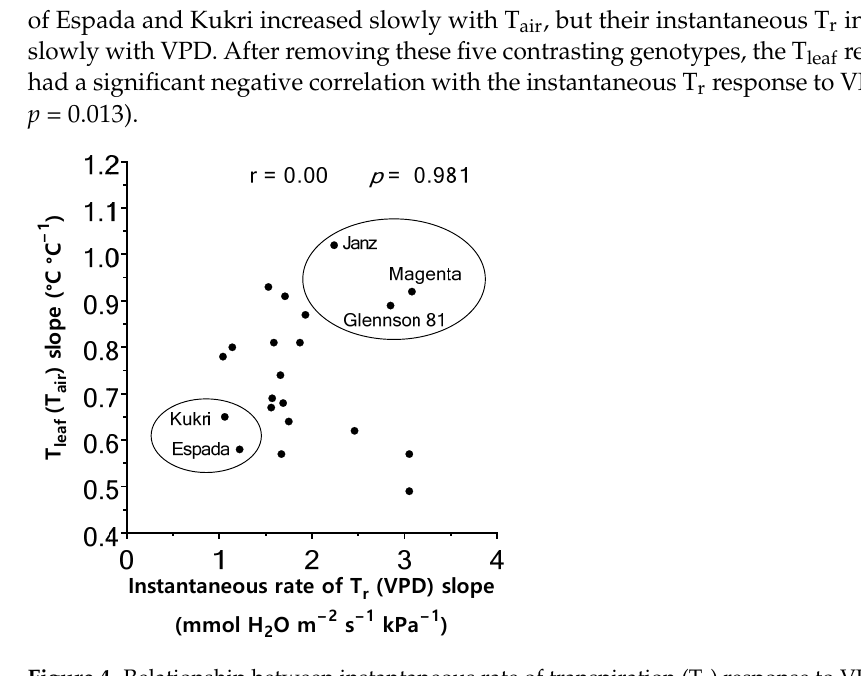
Figure 4. Relationship between instantaneous rate of transpiration (T r ) response to VPD (mean slope of instantaneous rate of T r response to VPD regression) and leaf temperature (T leaf ) response to air temperature (T air ) (mean slope of T leaf response to T air regression) of 20 wheat genotypes (two batches combined). Each data point represents an individual genotype. The genotypes circled do not conform to the expected model of negative linear correlation between T leaf (T air ) and instantaneous rate of T r (VPD) slopes.